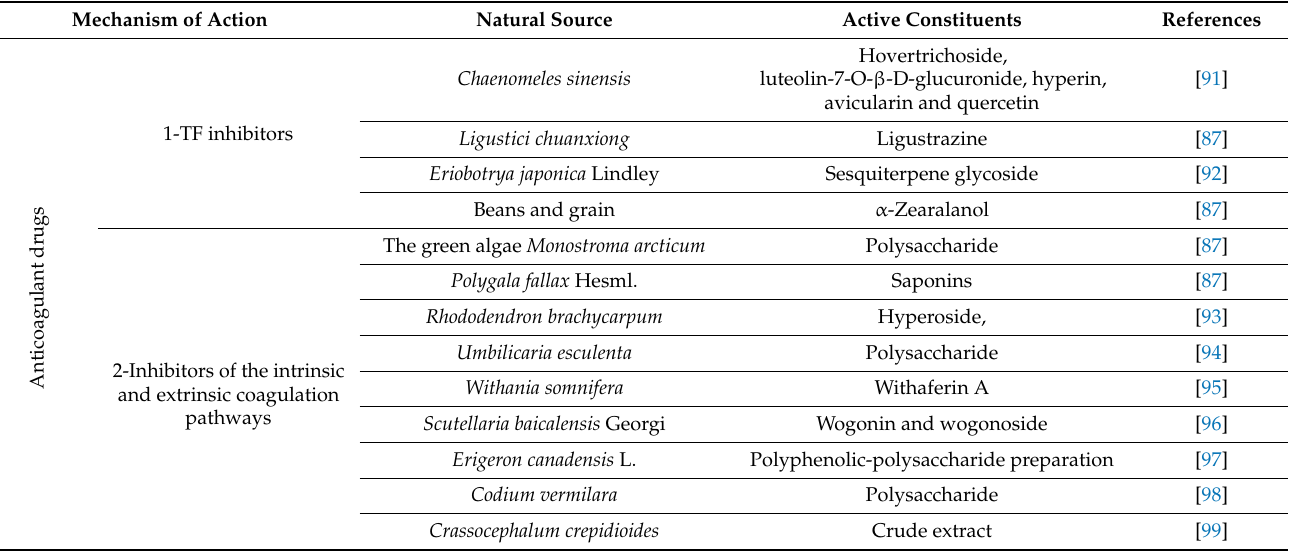
Table 1. Natural sources (for extracts or pure compounds) used as antithrombosis and their mecha- nisms of